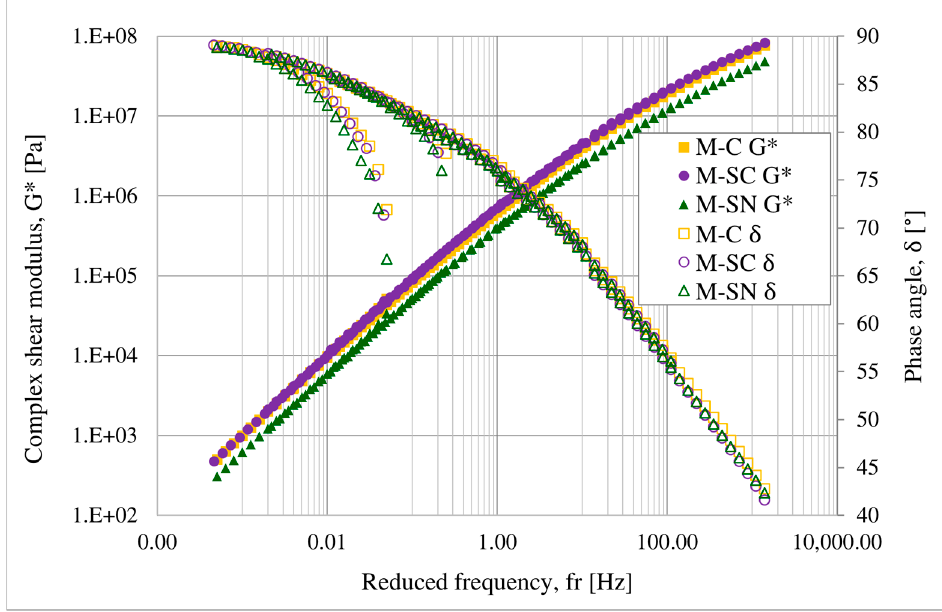
Figure 2. Complex modulus and phase angle master curves for all mastic samples.